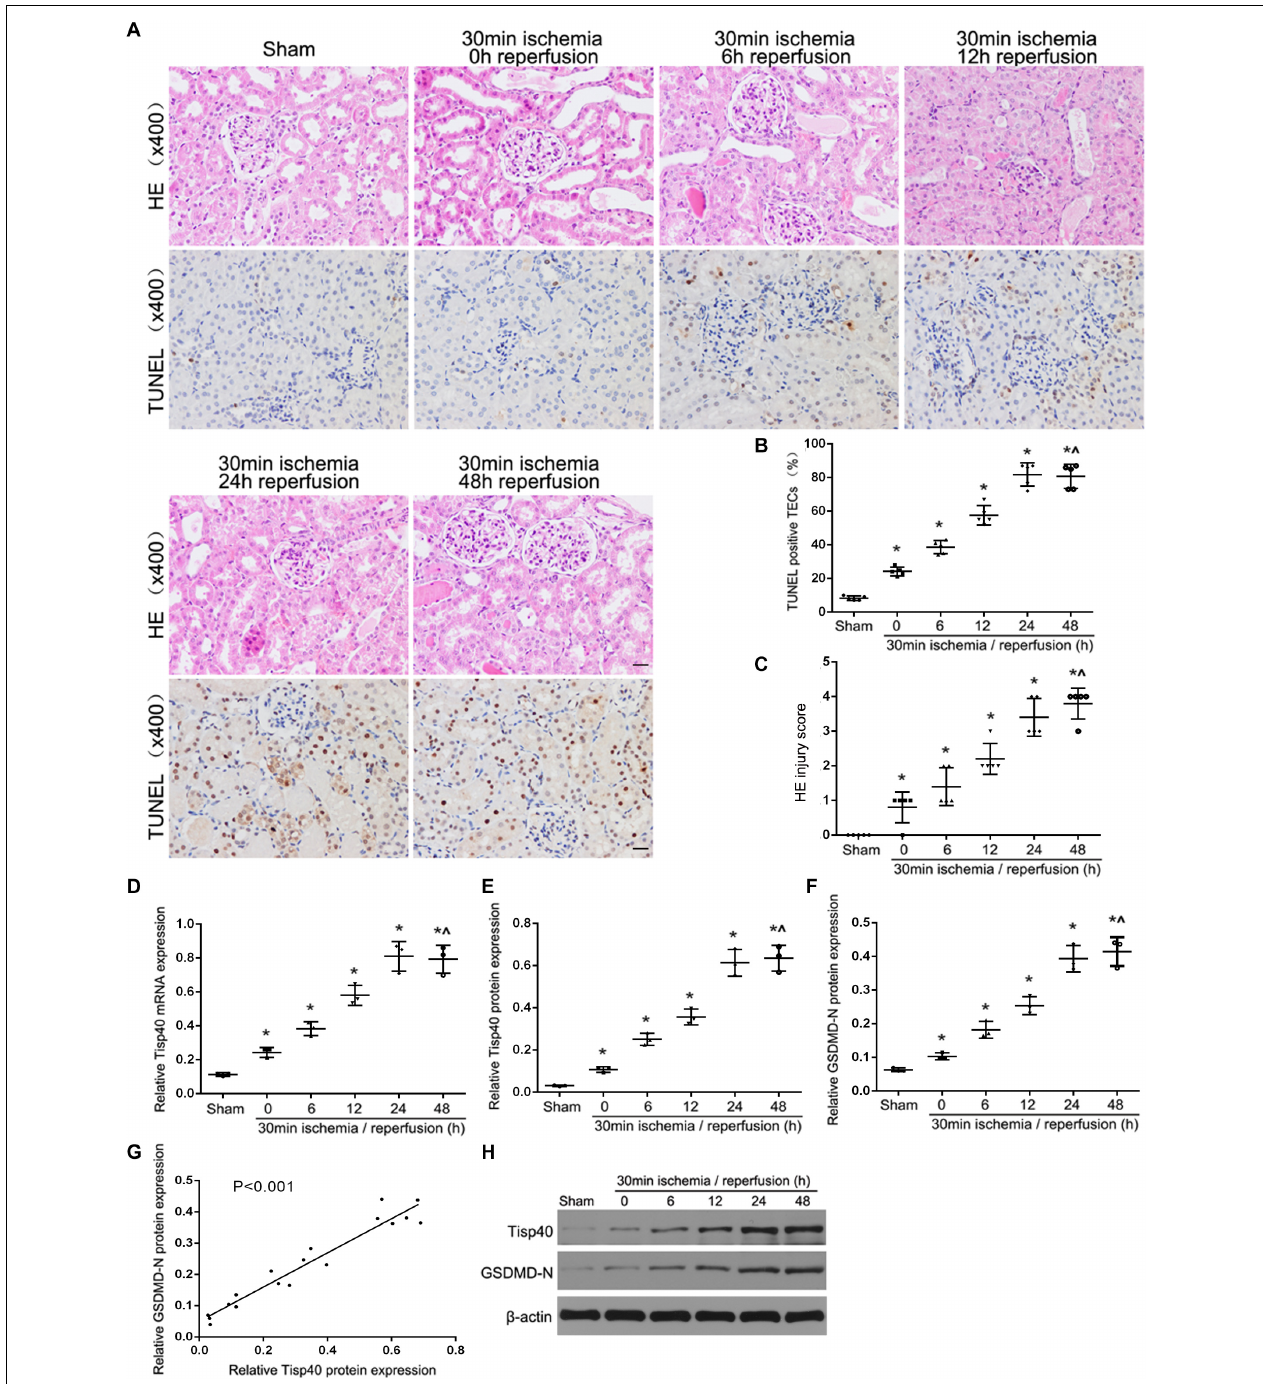
FIGURE 1 | Tisp40 and GSDMD-mediated pyroptosis of TECs were induced in I/R-induced kidney. (A) Representative photomicrographs of tubular cell injury in mouse kidney tissue sections with HE and TUNEL staining, 400 × , scale bar = 20 µ m. (B) Statistical analysis showed the percentage of TUNEL positive TECs in the kidney tissues exposed to 30 min ischemia followed by reperfusion of different durations. (C) Statistical quantification analysis showed the injury score of HE staining in the kidney tissues exposed to 30 min ischemia followed by reperfusion of different durations. (D,E,H) qRT-PCR and western blot analysis of Tisp40 expression at different reperfusion times after 30 min ischemia in kidney samples. (F,H) Western blot analysis of GSDMD-N protein expression at different reperfusion times after 30 min ischemia in kidney samples. (G) The correlation between the protein expression of Tisp40 and GSDMD-N was analyzed by Pearson’s correlation analysis in the kidney tissues. Data are expressed as the mean ± SD. n = 6 per group. * P < 0.05 vs. sham, ∧ P > 0.05 vs. 30 min ischemia and reperfusion of 24 h, one-way ANOVA.